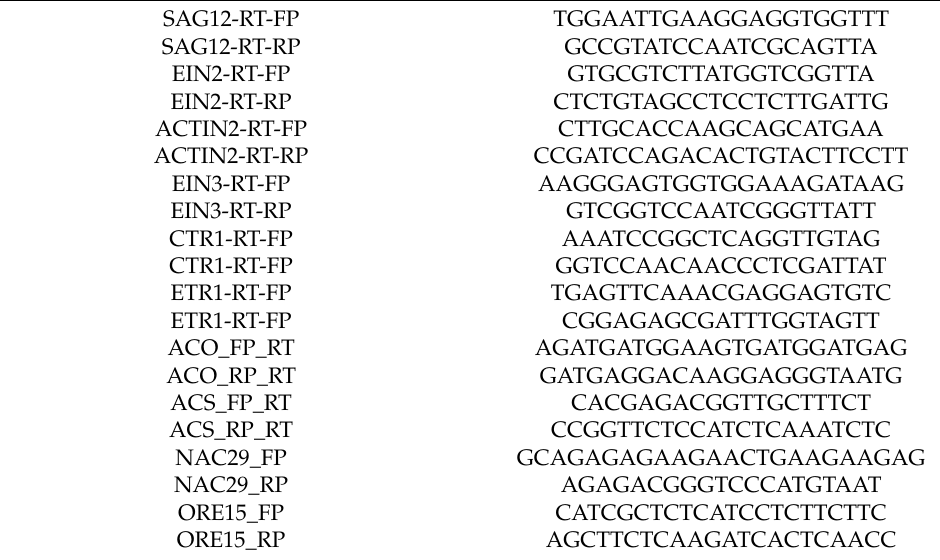
Table 1. List of primers used for real-time PCR analysis of ethylene biosynthesis and signaling genes and selected senescence-associated genes. Primers were designed using sequences from the Arabidopsis genome and designed with the help of Integrated DNA technologies (IDT)